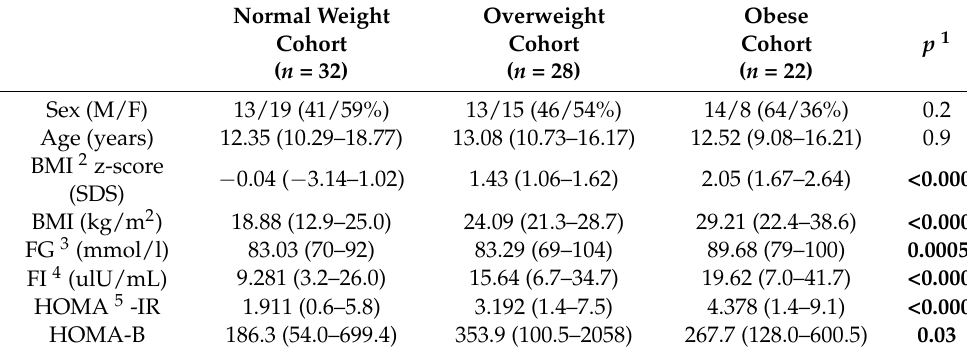
Table 1. Anthropometrics and biochemistry of